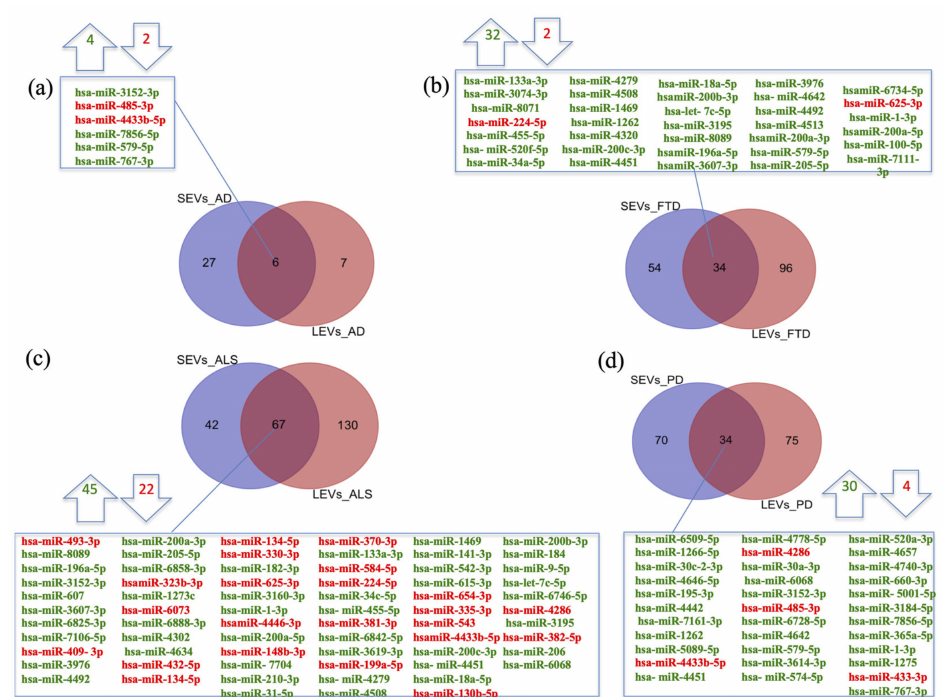
Figure 1. Common packaging of deregulated miRNAs into SEVs and LEVs of NDs. ( a ) In AD, of the 33 miRNAs found in SEVs and 13 in LEVs, 6 distribute to both, 4 up-regulated-in green and 2 down-regulated-in red; ( b ) In FTD, of the 88 miRNAs in SEVs and 130 in LEVs, 34 were in common (32 up-regulated and 2 down-regulated); ( c ) for ALS, of the 109 miRNAs in SEVs and 197 in LEVs, 67 were in common, 45 up-regulated and 22 down-regulated; ( d ) in PD, of the 104 miRNAs found in SEVs and 109 in LEVs, 34 distribute to both, 30 up-regulated and 4 down-regulated. Differential miRNA expression analysis by DESeq2 (log2FC > 1, p -value < 0.05). AD = Alzheimer Disease; FTD = Fronto-Temporal Dementia; ALS = Amyotrophic Lateral Sclerosis; PD = Parkinson Disease; CTRs = controls; SEVs = small extracellular vesicles; LEVs = large extracellular vesicles.